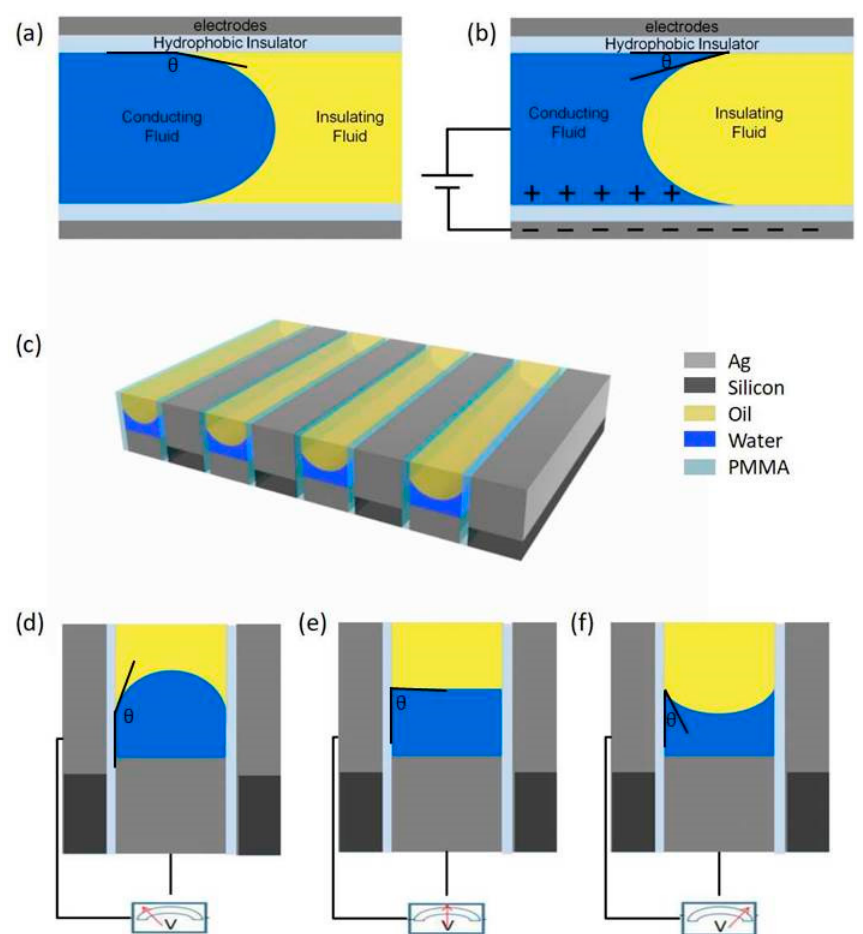
Figure 1. The principle of electrowetting is shown in ( a , b ). ( a ) The initial state and ( b ) indicates the situation after applying voltage. ( c ) The sketch of the model we created. In the figure, gray, black, yellow, blue and transparent areas respectively represent metallic silver, silicon elemental, oil, water and medium polymethyl methacrylate (PMMA). ( d – f ) The three different cases of the interface morphology after voltage application.